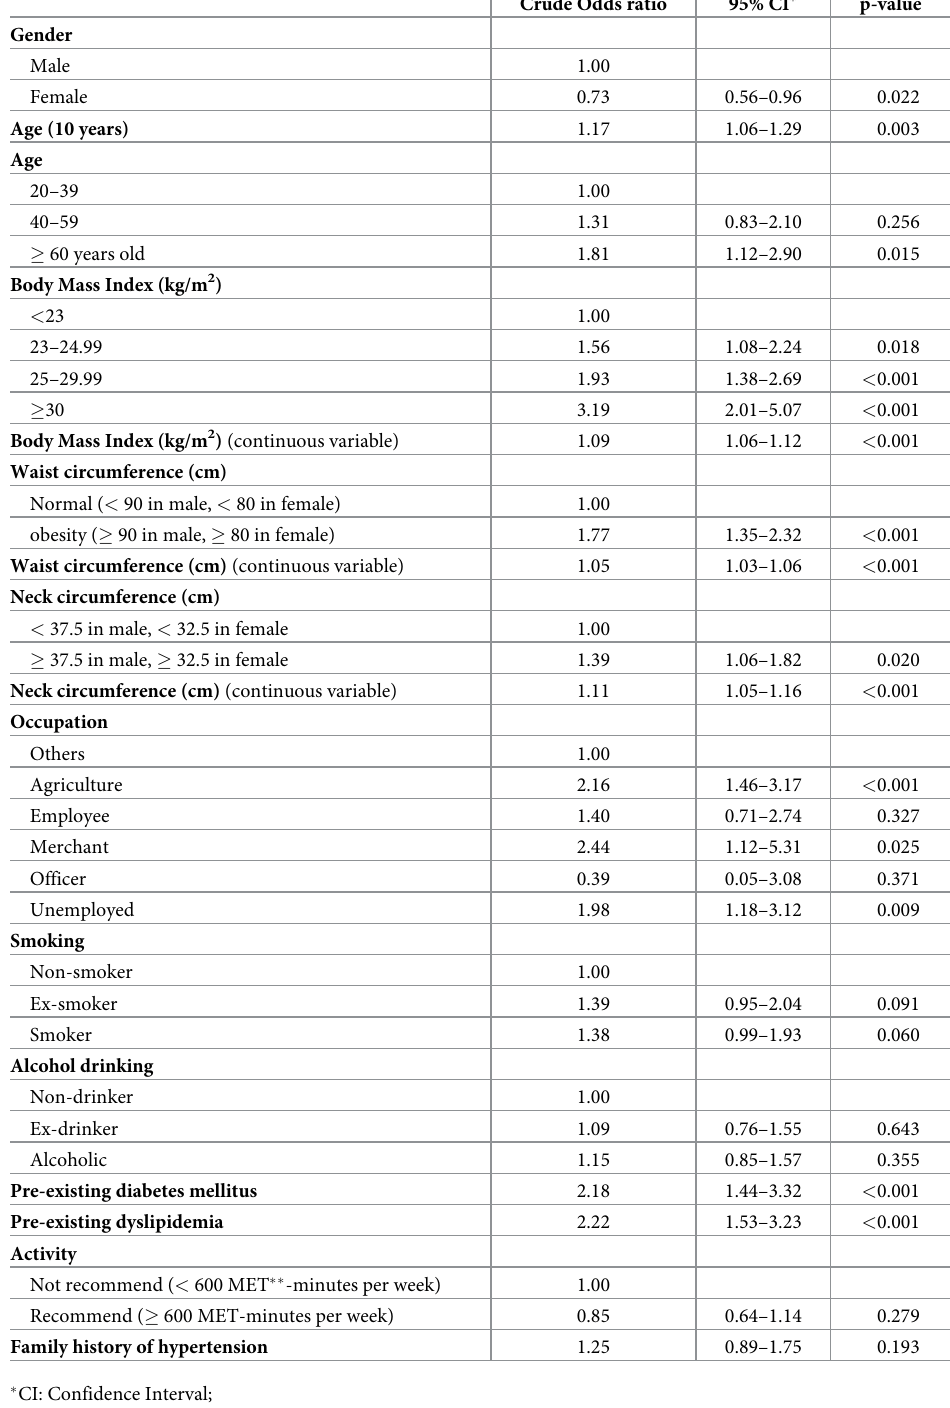
Table 2. Univariate logistic regression analysis to assess relationships between associated risk factor and hyper- tension in the rural communities in